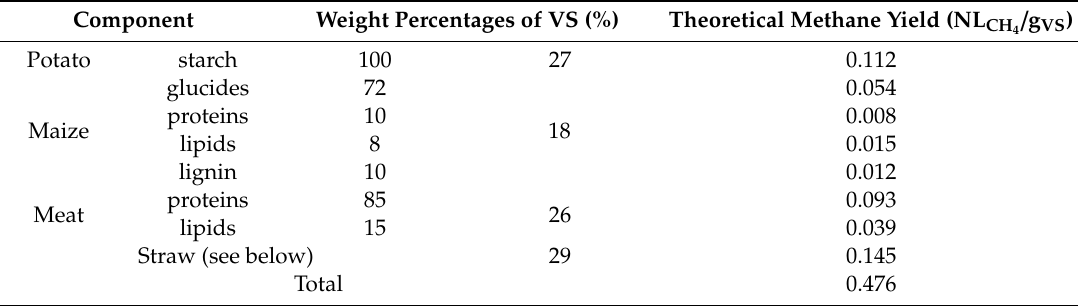
Table A2. Calculation of theoretical methane productivity of SA and SA’.